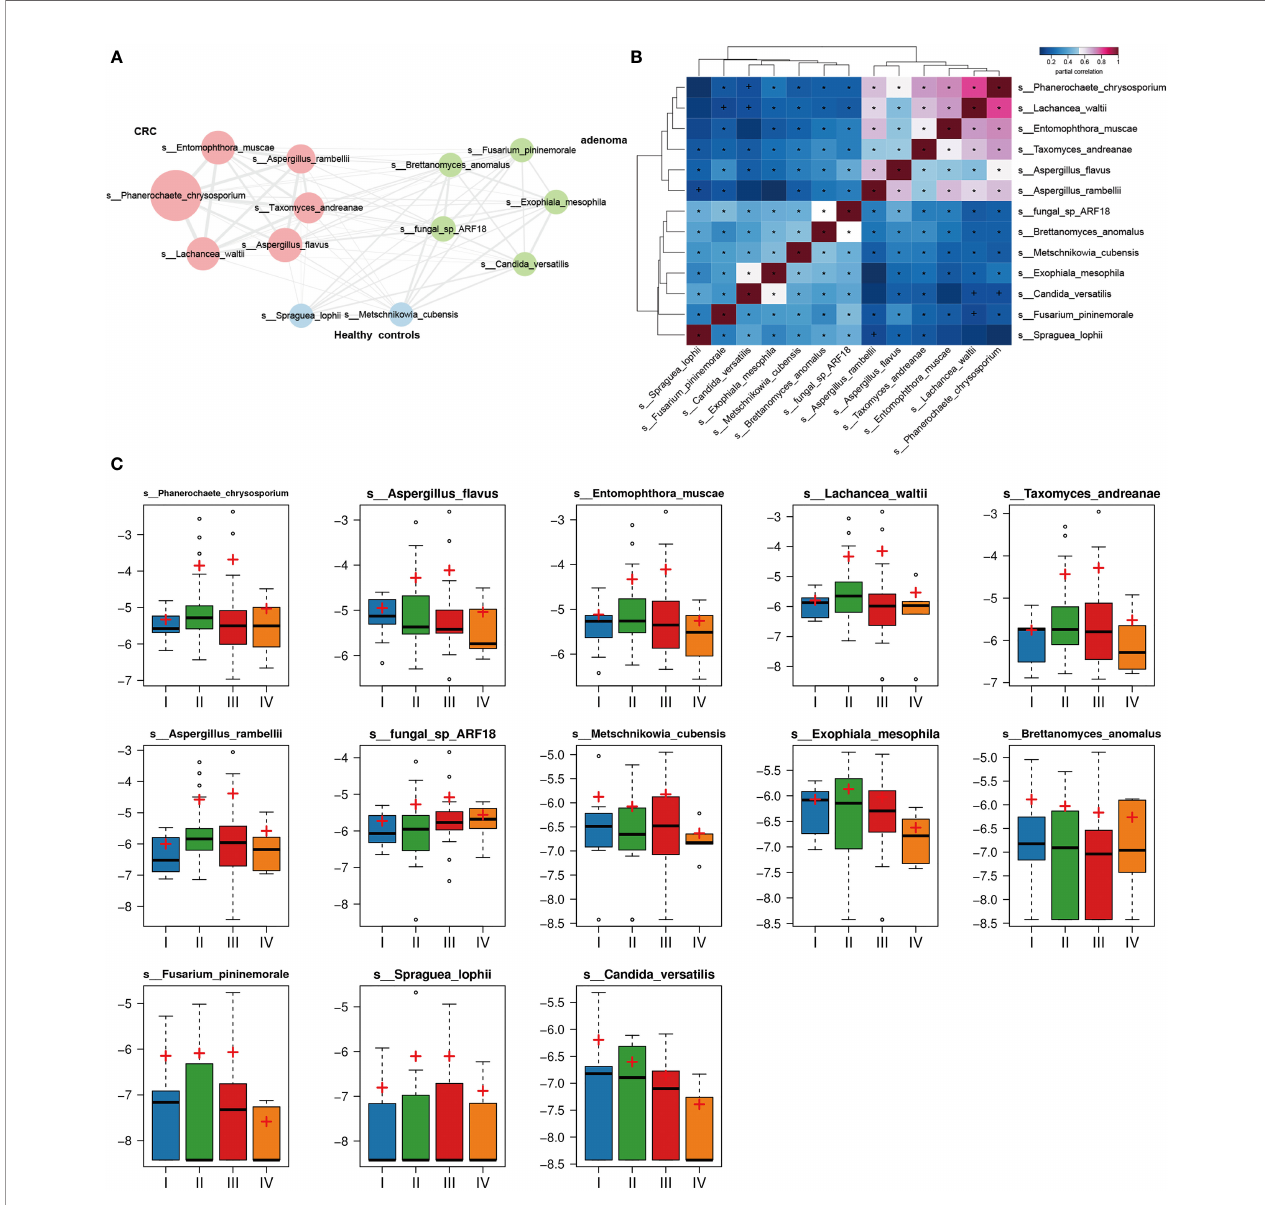
FIGURE 6 | The 13 mycobiota network in colorectal cancer (CRC), adenoma, and healthy controls. All mycobiota showed positive correlations in the network (A) . The heatmap displayed positive relationships among the selected 13 gut mycobiota (B) . The relative abundances of the 13 mycobiota in different stages (stages I, II, III, and IV) of CRC (C) . * p <